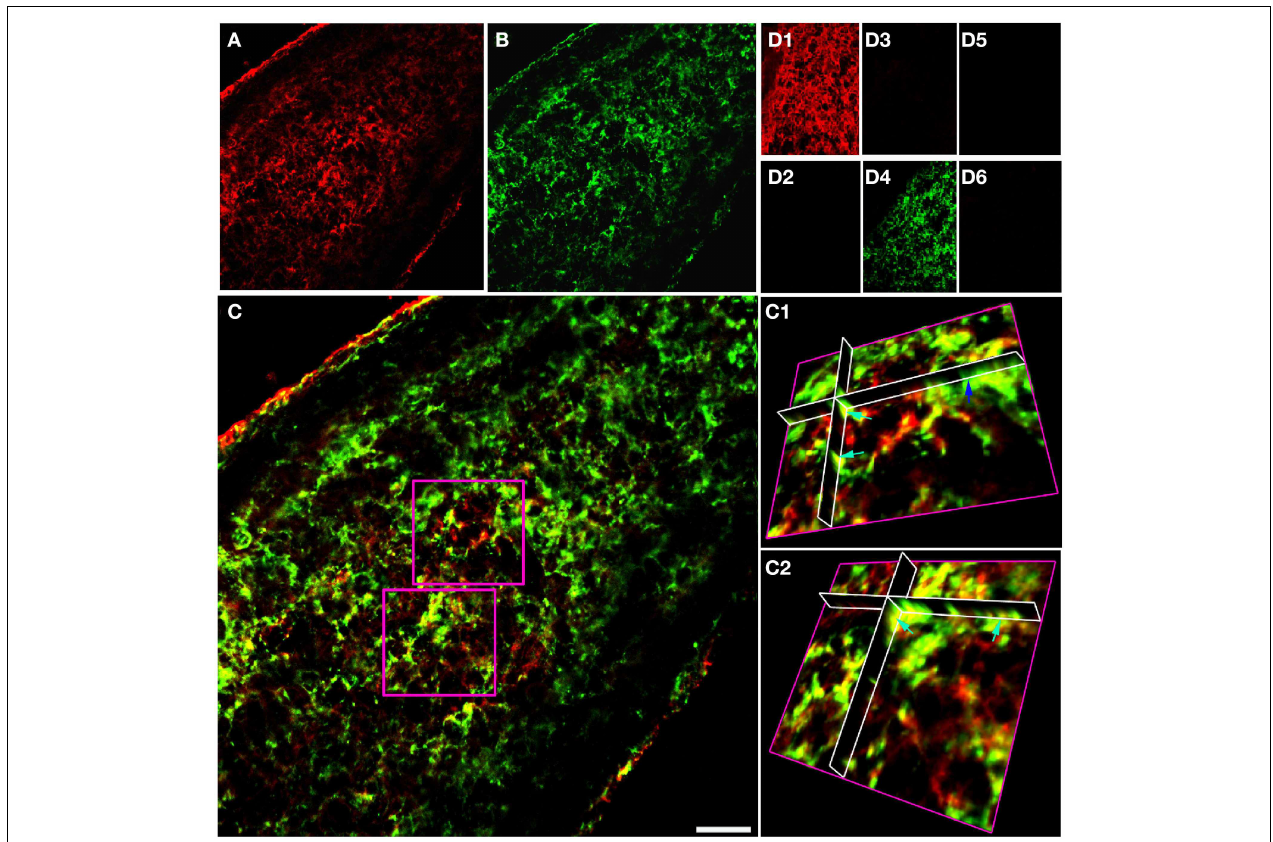
showing GFAP staining (D1) and absence of NG-2 staining (D2) when the NG-2 antibody was omitted from the otherwise identical protocol; NG-2 staining (D3) and no GFAP staining (D4) when the GFAP antibody was omitted, and the absence of any staining when both primary antibodies were omitted ( D5,D6 ). All images were collected and displayed using identical settings. Bar = 10 µ m.